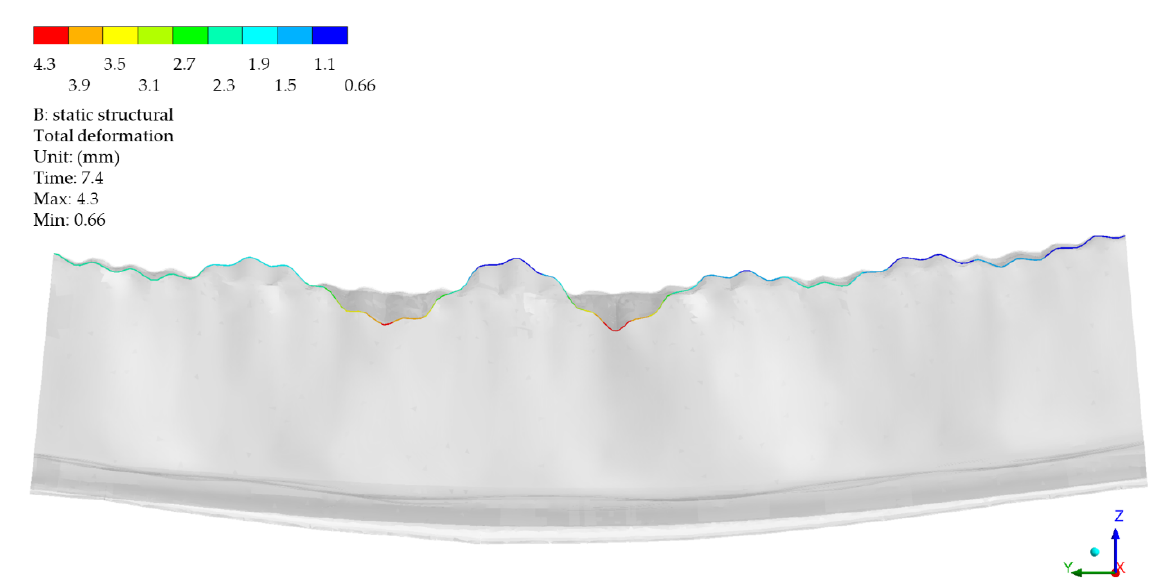
Figure 12. The deformation envelopes of the control points in the Y-axis. Global system.